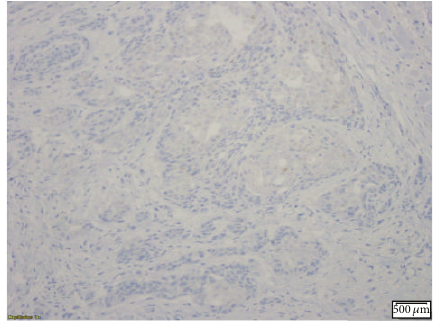
Figure 6: IHC stain positive for